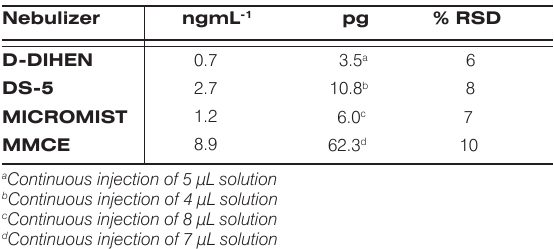
Table 3. Limits of detection (LOD) for copper and nebulizers tested. Continuous solution injection through make-up channel without application of voltage.